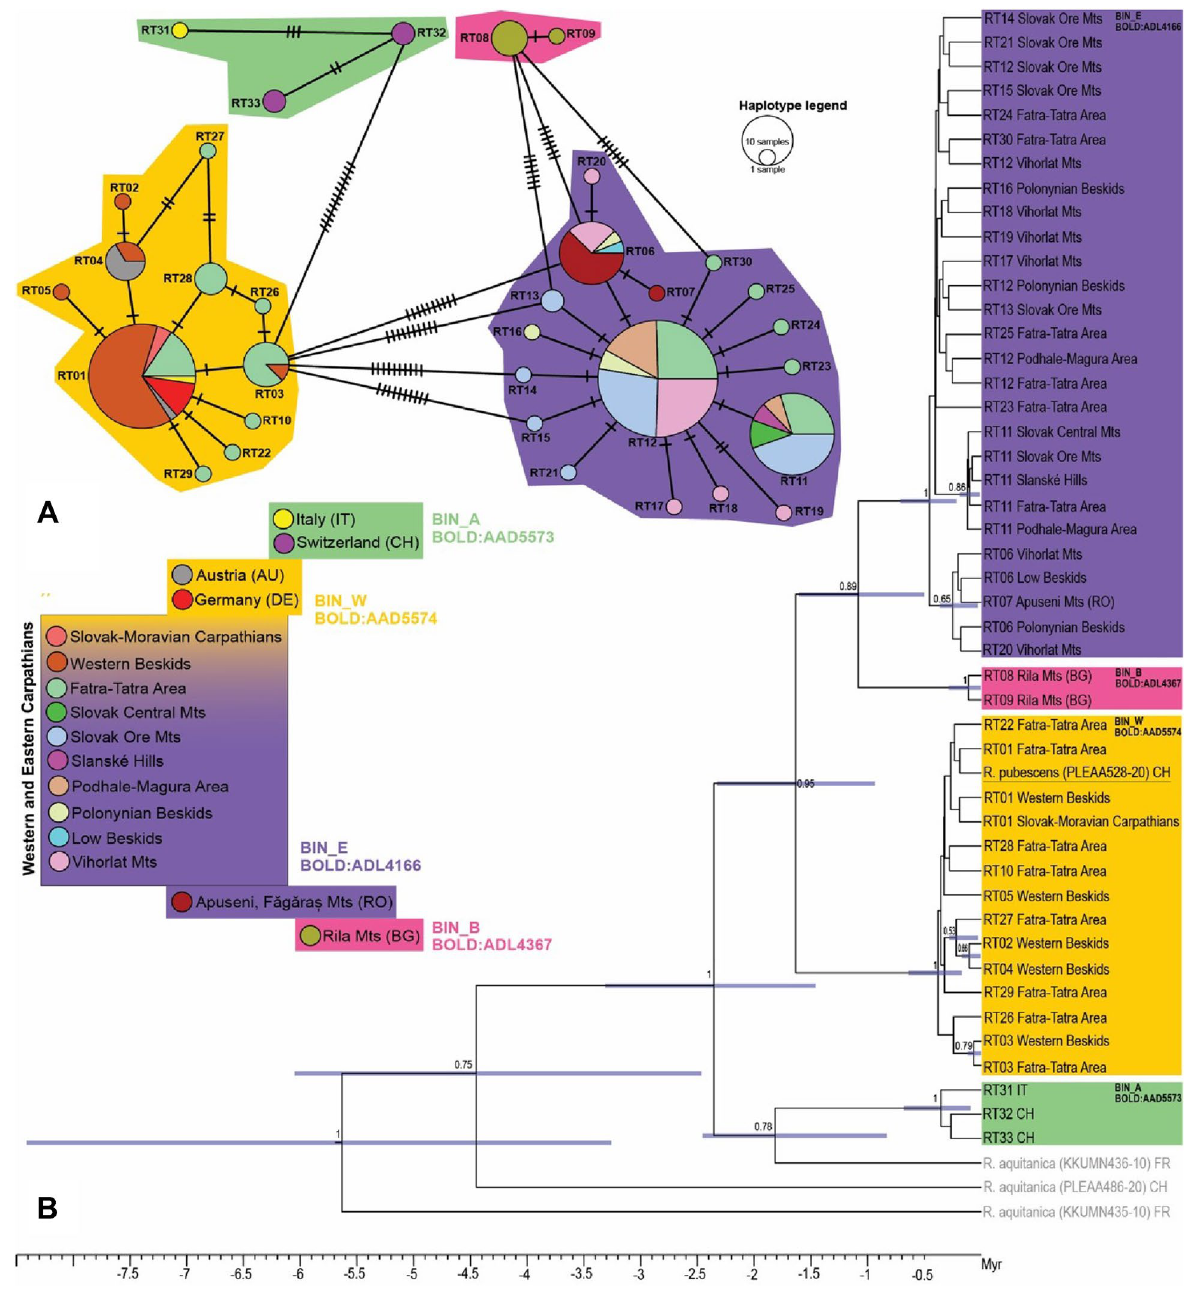
Figure 3. The genetic diversity of the R. tristis BINs in the studied area. ( A ) Median-Joining haplotype network (5 ′ COI mtDNA) showing the relationships among haplotypes RT01–RT33 (including available haplotypes from outside of the studied area). Groups of haplotypes form four BINs (BIN_W, BIN_E, BIN_B, BIN_A), which are colour-coded in the haplotype network according to the legend; ( B ) Bayesian time calibrated phylogenetic reconstruction of R. tristis based on COI 5 ′ region. Numbers near nodes are posterior probabilities. Node bars are 95% HPD of the divergence time. The outgroup consisted of the European congeneric species R. aquitanica the differences among subpopulations within physiographic units (PU) or river basins (RB). In the BIN_W, the variation at this level was negligible, however, influence of the division into PU/RB was suggested (Table 2). The F ST values indicate a similar range of genetic differentiation within both BINs (Fig. S1). They showed that localities are relatively well connected in both BINs, but some level of isolation could not be refused among several subpopulations. The tests of isolation by distance revealed a positive correlation (Mantel test: r = 0.601; p-value = 0.001), supported also by the significant spatial autocorrelation (p-value = 0.000; Fig. S2). Such a posi- tive and statistically significant correlation suggests a structuring effect of the geographical distance among studied localities.